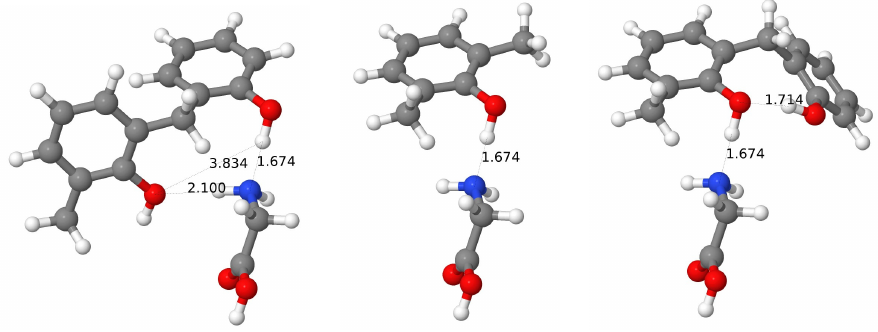
Figure 9. The fragments 3, 6, and 7 generated from the SSMF3 partitioning of the wc -CX interacting with Gly. The numeration goes from left to